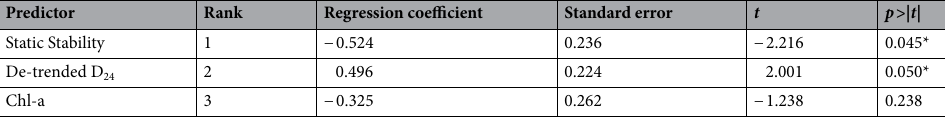
Table 2. Multiple linear regression analysis with annual oil sardine landings the predictand and parameters such as static stability, de-trended D 24 , and chlorophyll as predictors for the period 2004–2018. D 24 : Depth of 24 degree isotherm, Chl-a: chlorophyll- a . *denotes the values that are statistically significant at p <